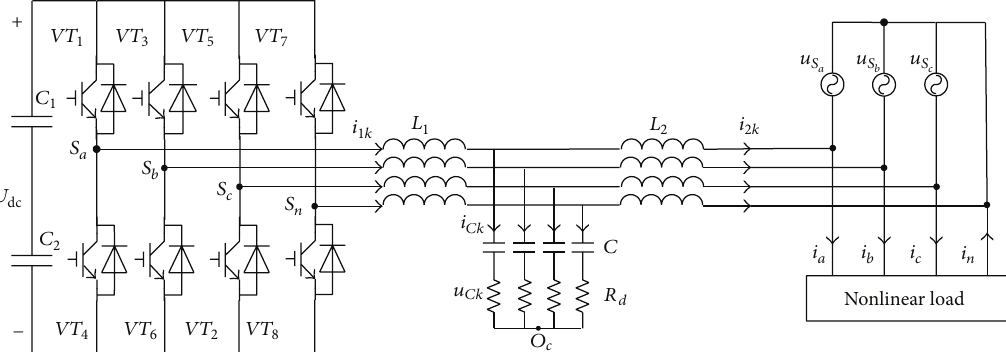
Figure 3: The main circuit of the three-phase four-leg